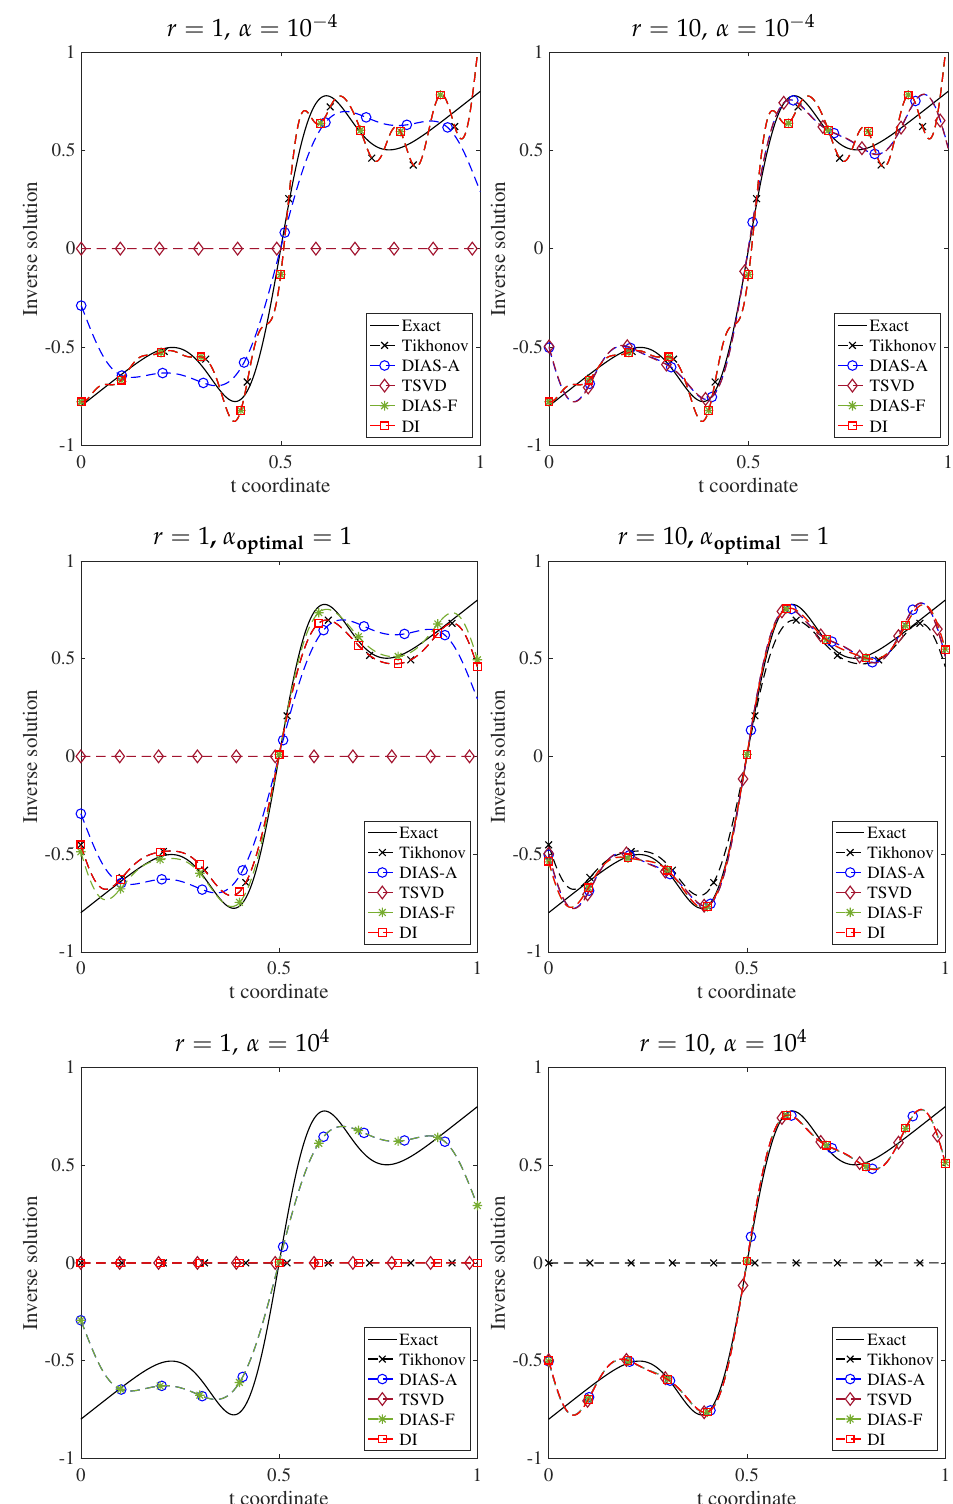
Figure 2. Solutions for 1D deconvolution problem with different active subspace dimensions r = 1, 10 and different regularization parameter values α = 10 − 4 , 1, 10 4